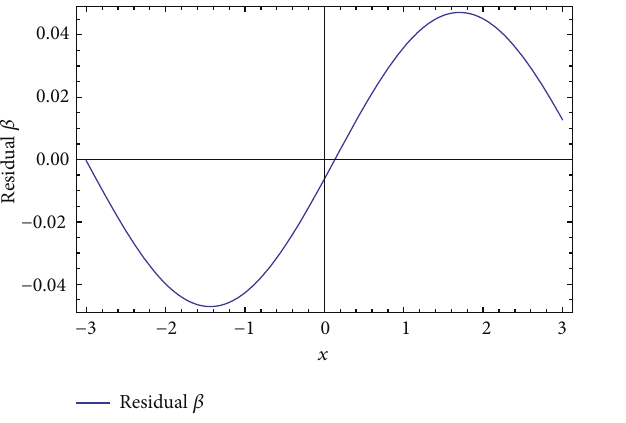
Figure 16: 2D, residual of 𝛽(𝑥,𝑡) at 𝑡 = 0.1 .